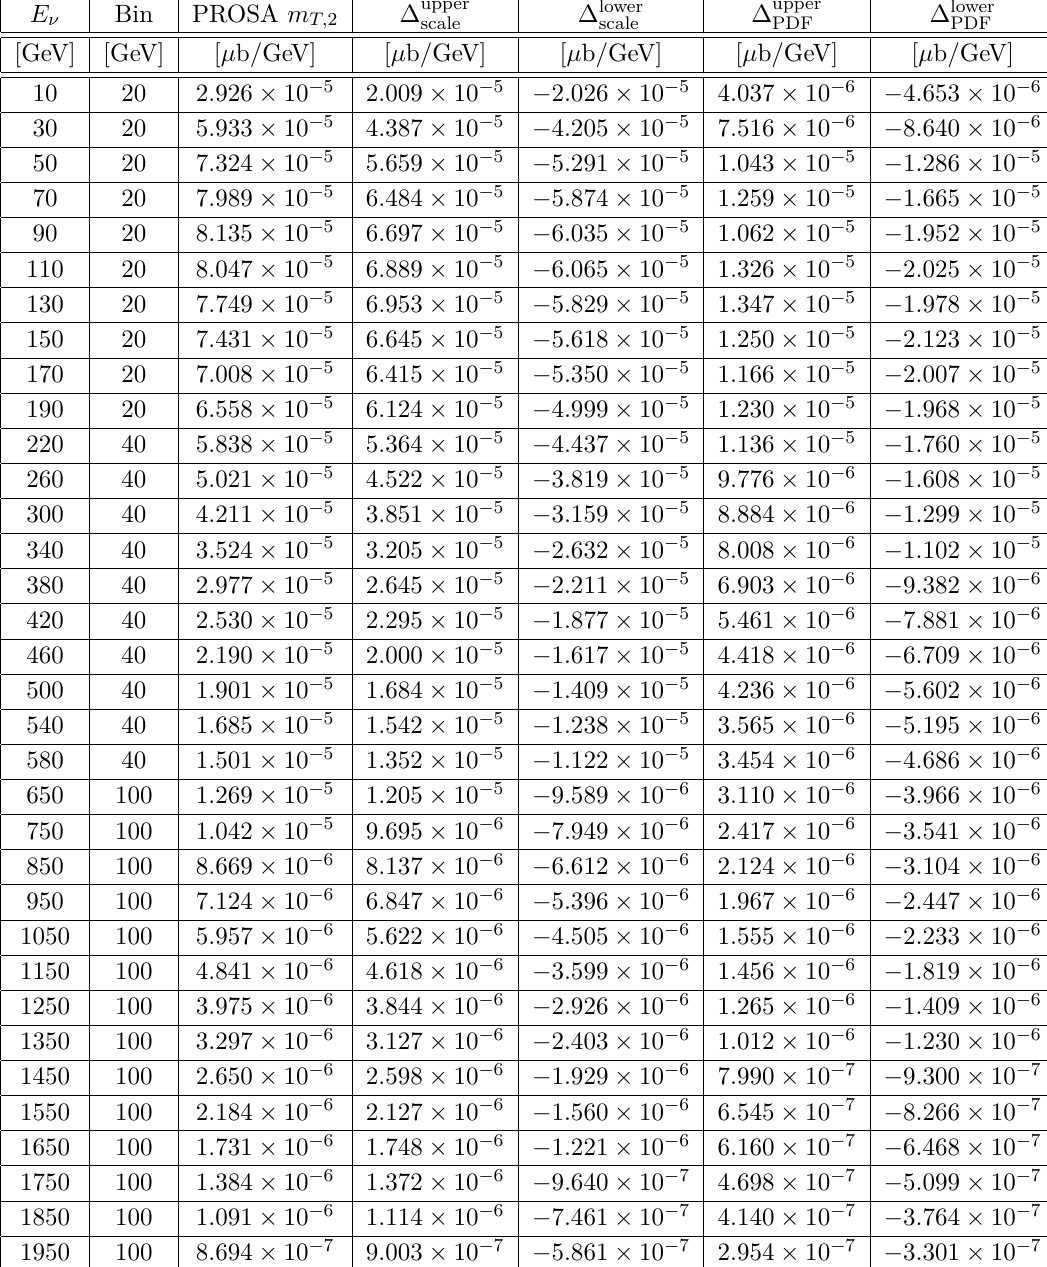
√ s = 14 TeV, η ν > 8 . 9 . The predictions